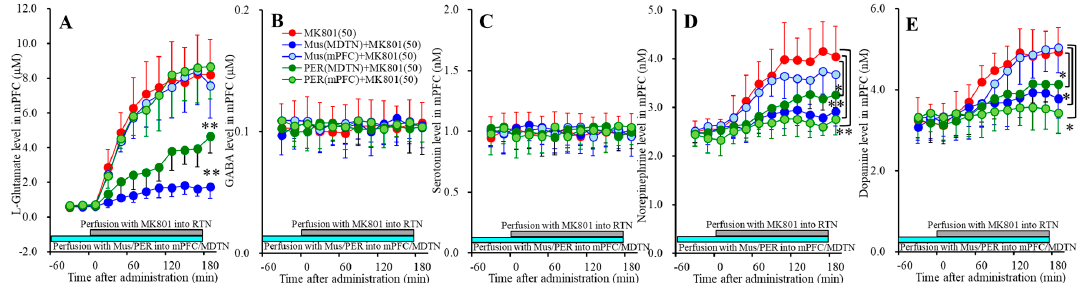
Figure 4. E ff ects of local administration of muscimol and perampanel into the medial prefrontal cortex (mPFC) and mediodorsal thalamic nucleus (MDTN) on 50 μ M RTN MK801-induced releases of l -glutamate ( A ), GABA ( B ), serotonin ( C ), norepinephrine ( D ), and dopamine ( E ) in the mPFC (Study_3). Ordinates: mean ± SD ( n = 6) of extracellular transmitter levels ( μ M or nM); abscissa: time after MK801 administration (min). Light blue bars indicate perfusion with 1 μ M muscimol (Mus) or perampanel (PER) into the mPFC or MDTN. Gray bars indicate the perfusion with 50 μ M MK801 into the RTN. * p < 0.05, ** p < 0.01; relative to control (50 μ M MK801) by MANOVA with Tukey’s post hoc test.